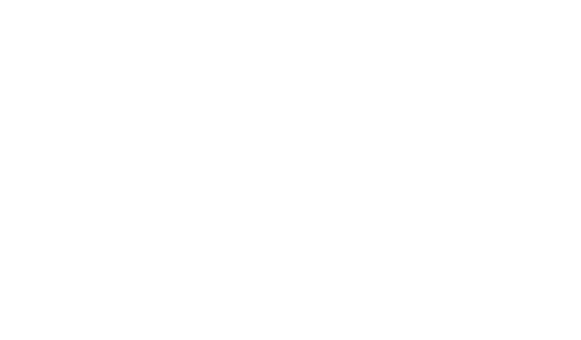
Figure 2. Force of screw blade on fertilizer particles. Note: F is the total force of screw blade acting on fertilizer particles, N; F N is the normal pressure of screw blade on fertilizer particles, N; f s is the friction force of screw blade on fertilizer particles, N; P 1 is the axial component of F , N; P 2 is the circumferential component of F , N; α is the friction angle between blade and fertilizer, ( ◦ ); β is the lift angle of screw blade, ( ◦ ); r is the distance between particles and axis of screw shaft,